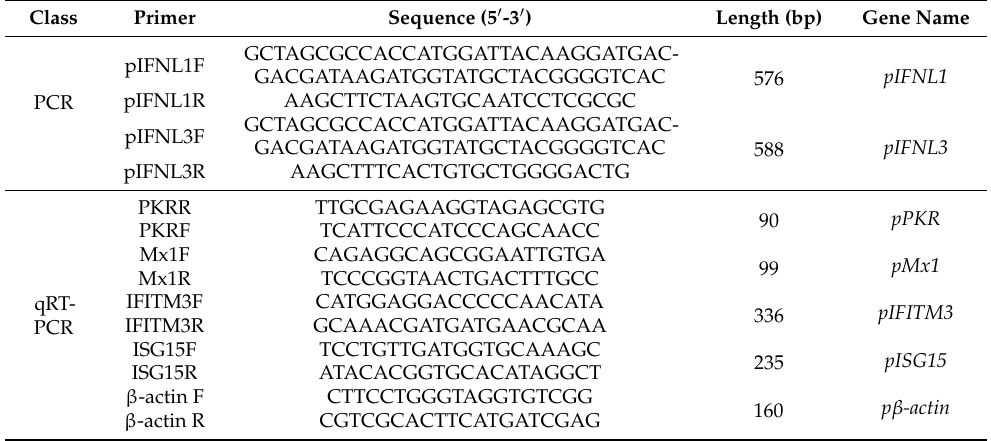
Table 1. Primers in this